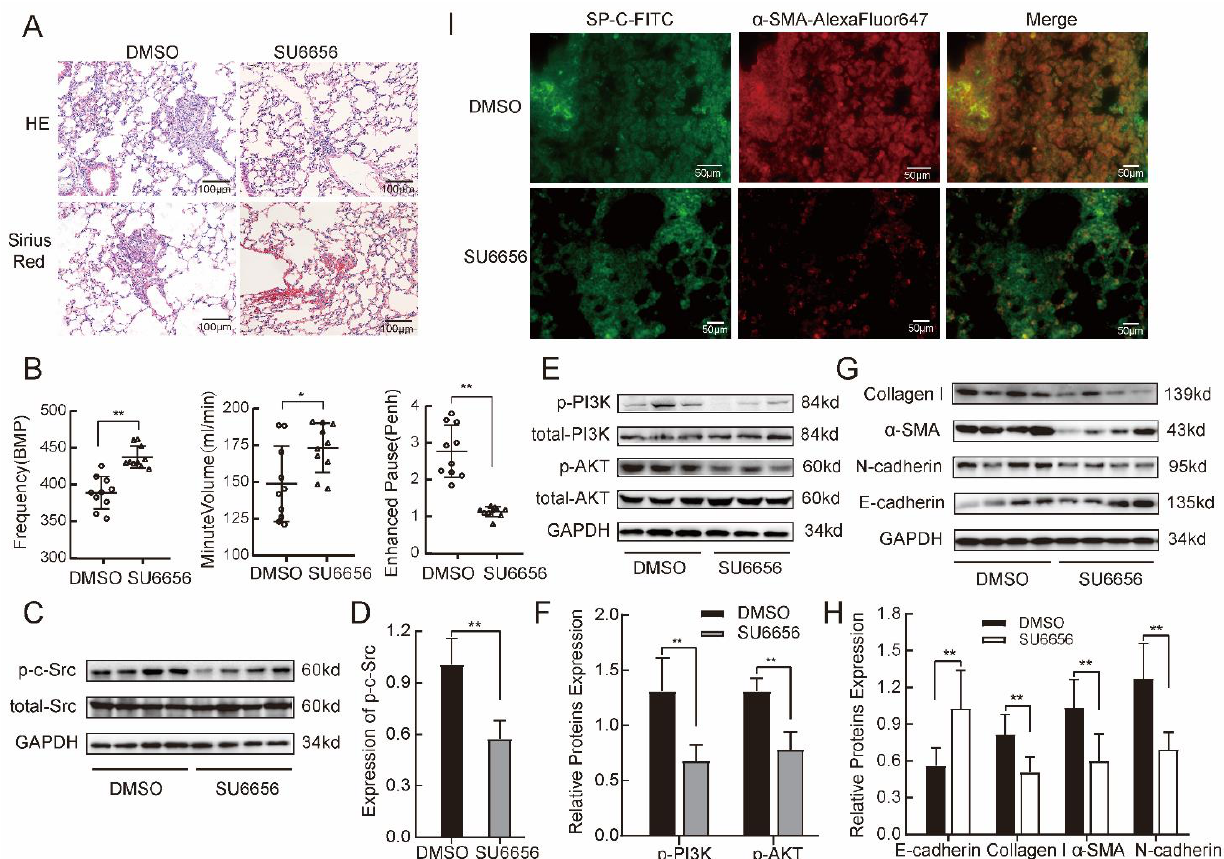
Figure 6. SU6656 inhibited p-c-Src to suppress PI3K/AKT pathway activation and prevent fibrosis in mice models of silicosis. ( A ) SU6656 reduced nodules and collagen deposition in lung tissue with HE and Sirius Red staining. ( B ) SU6656 improved lung function through increased frequency ( F ) and minute volume (MVb) and decreased pause (Penh). Note: Hollow circles represent the DMSO group, hollow triangles represent the SU6656 group. ( C , D ) SU6656 inhibited phosphorylated c-Src protein in fibrotic pulmonary. ( E , F ) SU6656 decreased phosphorylation of PI3K and AKT in lung tissue compared with DMSO group. ( G , H ) SU6656 reversed fibrosis with Western blot measures (decreased Col Ⅰ , α -SMA, and N-cadherin and increased E-cadherin). ( I ) Immunofluorescence staining showed SP-C (green-fluorescent) and α -SMA (red-fluorescent) co-localization in the SU6656-treated group and the DMSO groups. Independent-samples t -test. Values are mean ± SD, n = 6. * p < 0.05, ** p < 0.01 versus DMSO group.